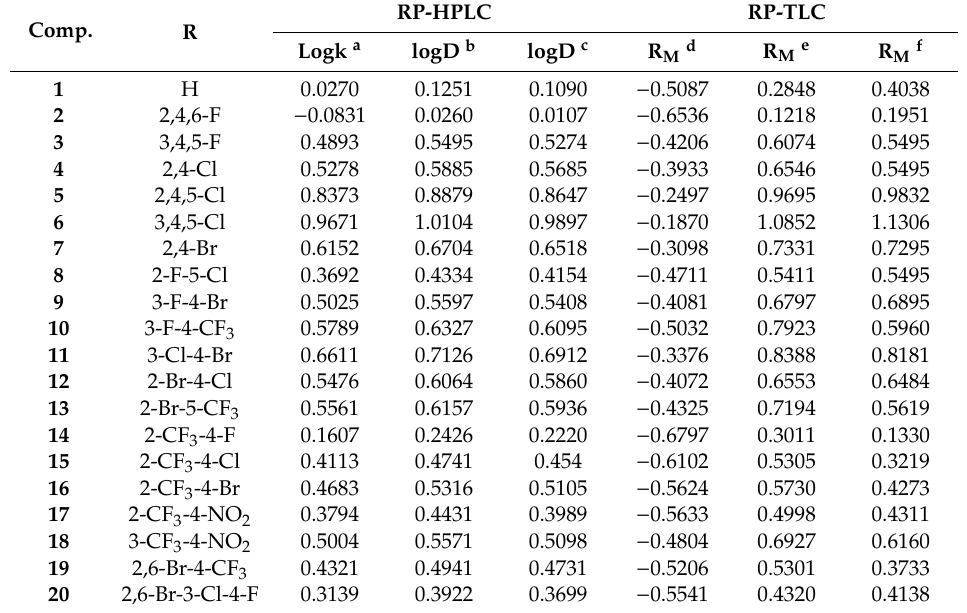
Table 2. Experimentally found lipophilicity determined using HPLC and TLC approaches for N -arylcinnamanilides 1 – 20